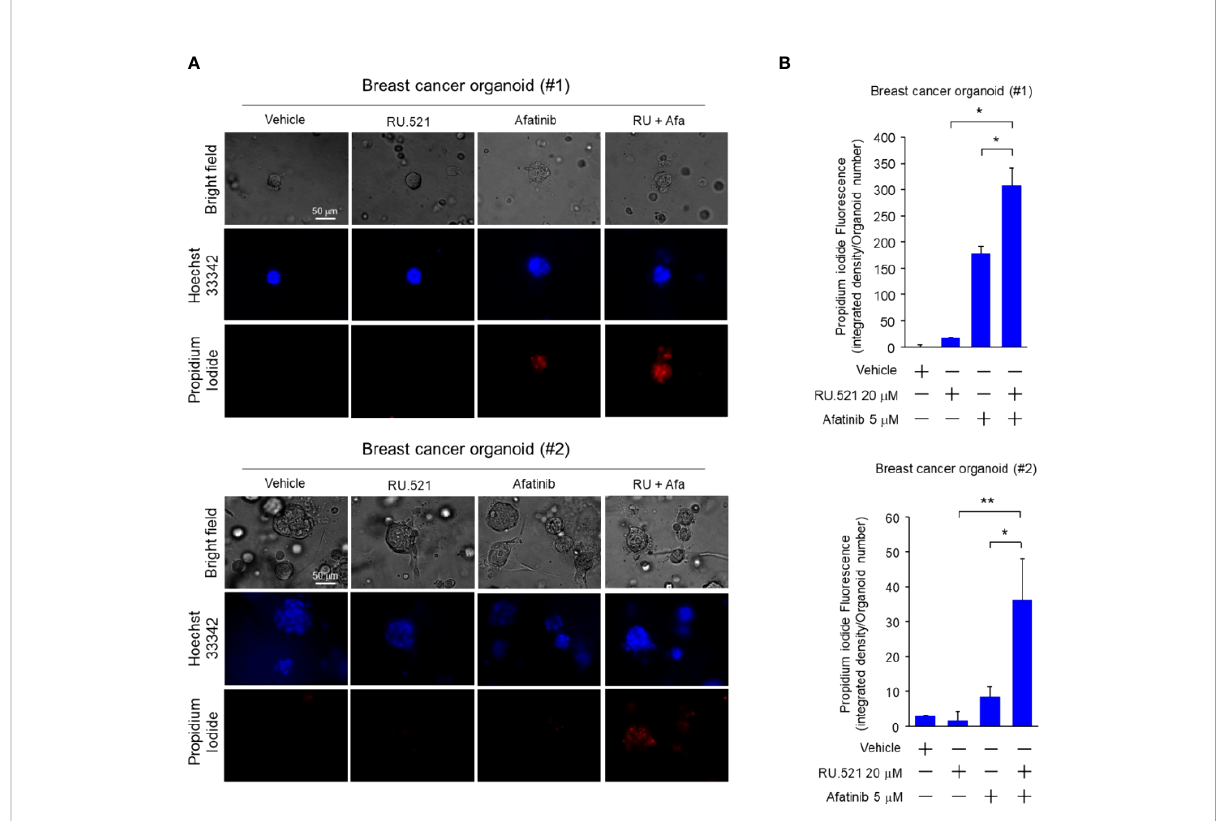
FIGURE 8 Combined treatment by RU.521 and afatinib induced death of tumor cells of the PDTOs. The tumor organoids derived from breast cancer patients were cultured and treated with RU.521 alone (20 m M), afatinib alone (5 m M), or co-treated with RU.521 plus afatinib in serum-replete media for 72 hr. n, the number of organoids tested in each treatment are indicated. (A) , The organoids were stained by Hoechest 33342 and propidium iodide for 1 hr, and fl uorescent images were captured by a fl uorescence microscope at 400x magni fi cation. The images of representative organoids including the corresponding bright fi eld images are shown. (B) , The fl uorescence intensities of the organoids were quantitated and plotted. The data of three independent experiments were shown as means ± SD, and statistical signi fi cance was plotted by Student ’ s t-test. *, p < 0.05; **, p <